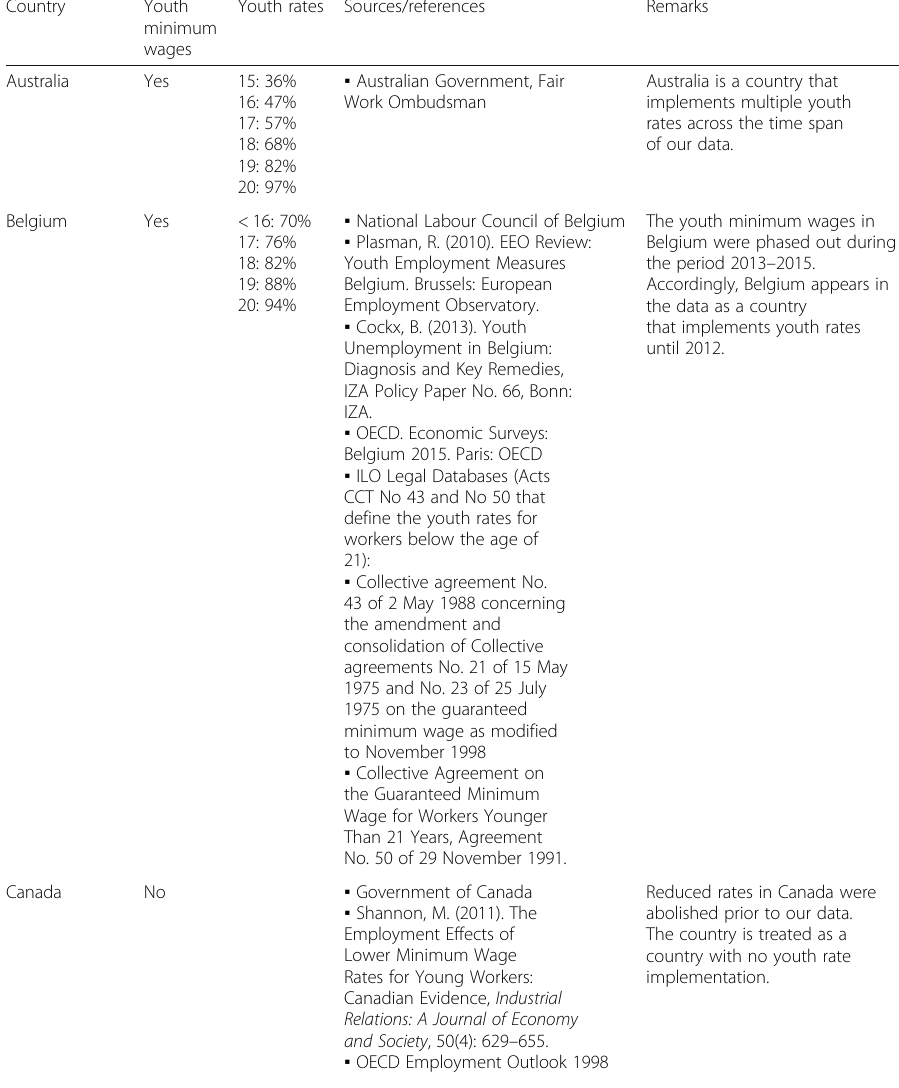
Table 6 Youth minimum wage systems for selected OECD countries Country